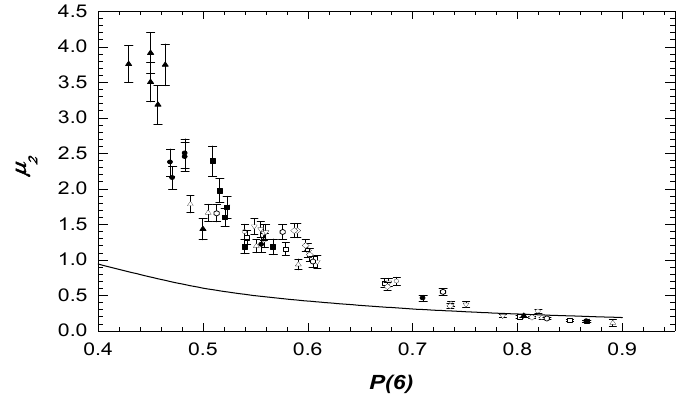
Figure 7. A plot of µ 2 against P (6) for the various grain boundaries. The line represents Equation (1).